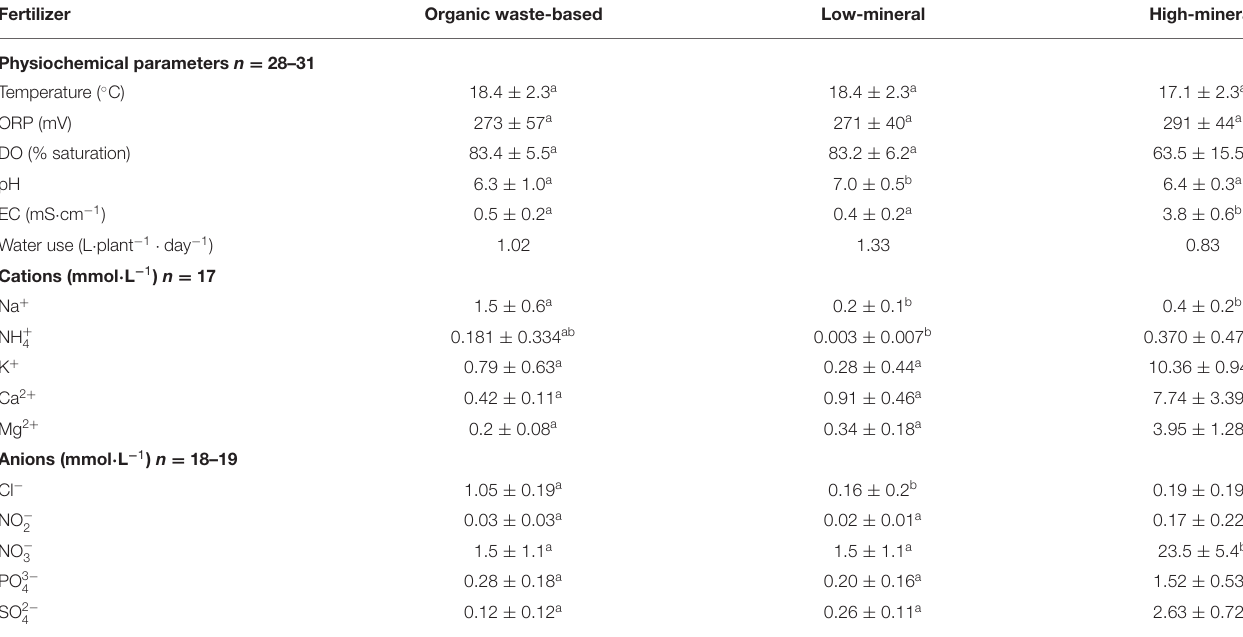
TABLE 1 | Physiochemical parameters and ionic composition of the tested treatments. Fertilizer Organic waste-based